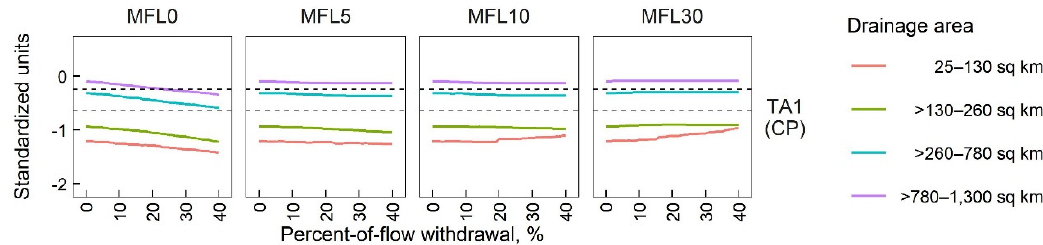
Figure 5. Mean responses of select streamflow characteristics to incremental percent-of-flow withdrawal scenarios and minimum flow levels (MFL) within the Cumberland Plateau (CP). Solid lines represent mean values across sites for each drainage-area size; horizontal dashed lines are the interquartile range (IQR) of SFCs from reference sites within the ecoregion [38,39,41].